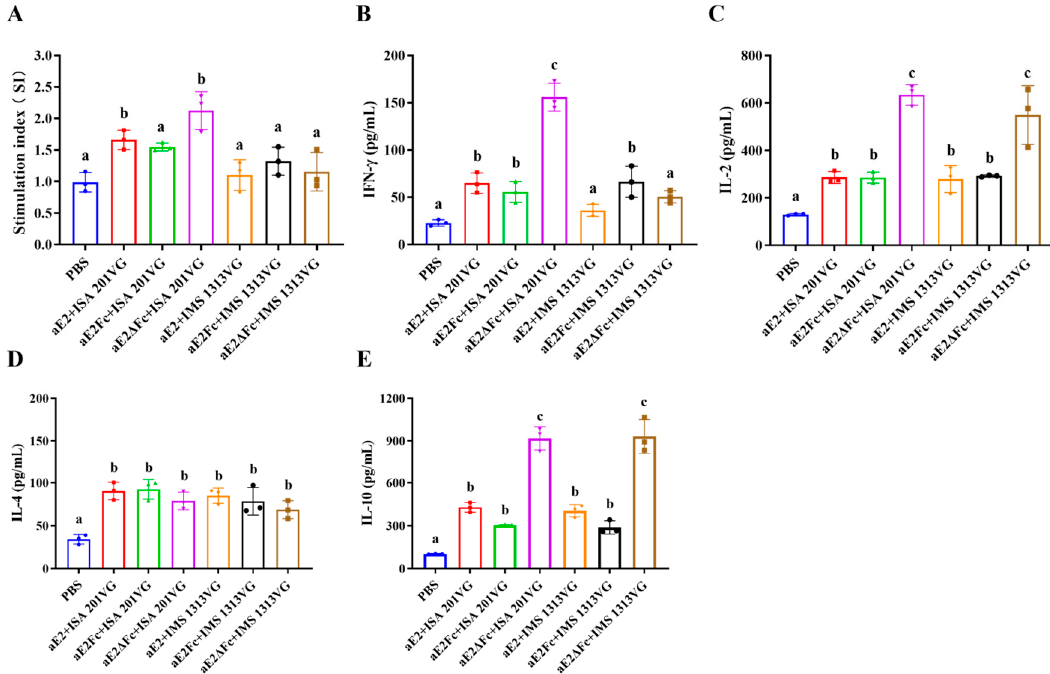
Figure 6. Lymphocyte proliferation assay and detection of cytokines. ( A ) Detection of lymphocyte proliferative responses. ( B – E ) Detection of the levels of cytokines in the supernatants of stimulated lymphocytes from piglets immunized with the APPV E2 subunit vaccines. Different letters (a, b, c) indicate a statistically significant difference between different experimental groups ( p < 0.05). Experiments were conducted independently in triplicates. Data are represented as the mean ± SD (n =